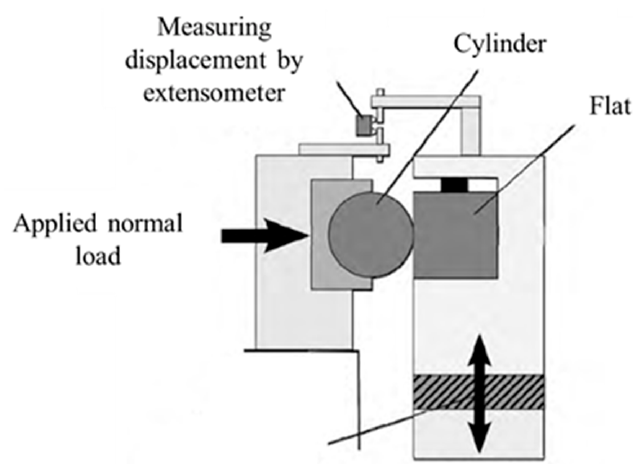
Figure 4. Sketch of the experimental setup.